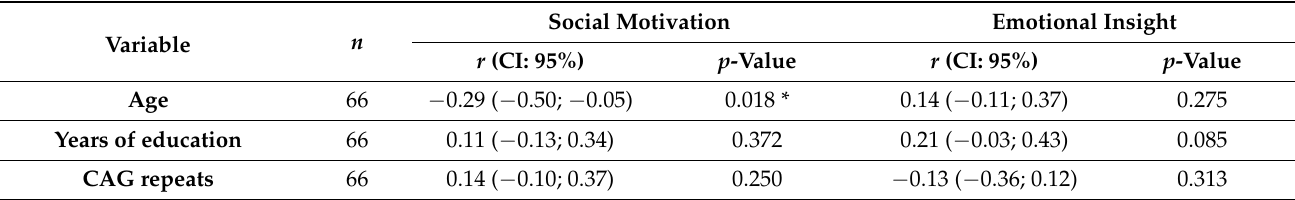
Table A1. Pearson’s correlations analysis in HD at